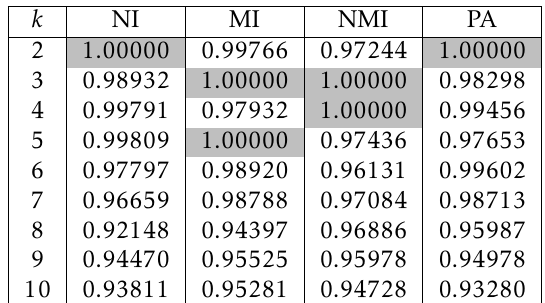
Table 3. Stability metrics of clustering results of k